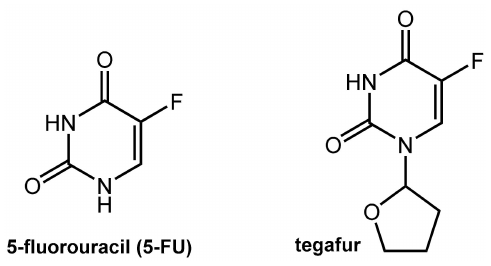
Figure 15. Structures of 5-fluorouracil (5-FU) and its pro-drug